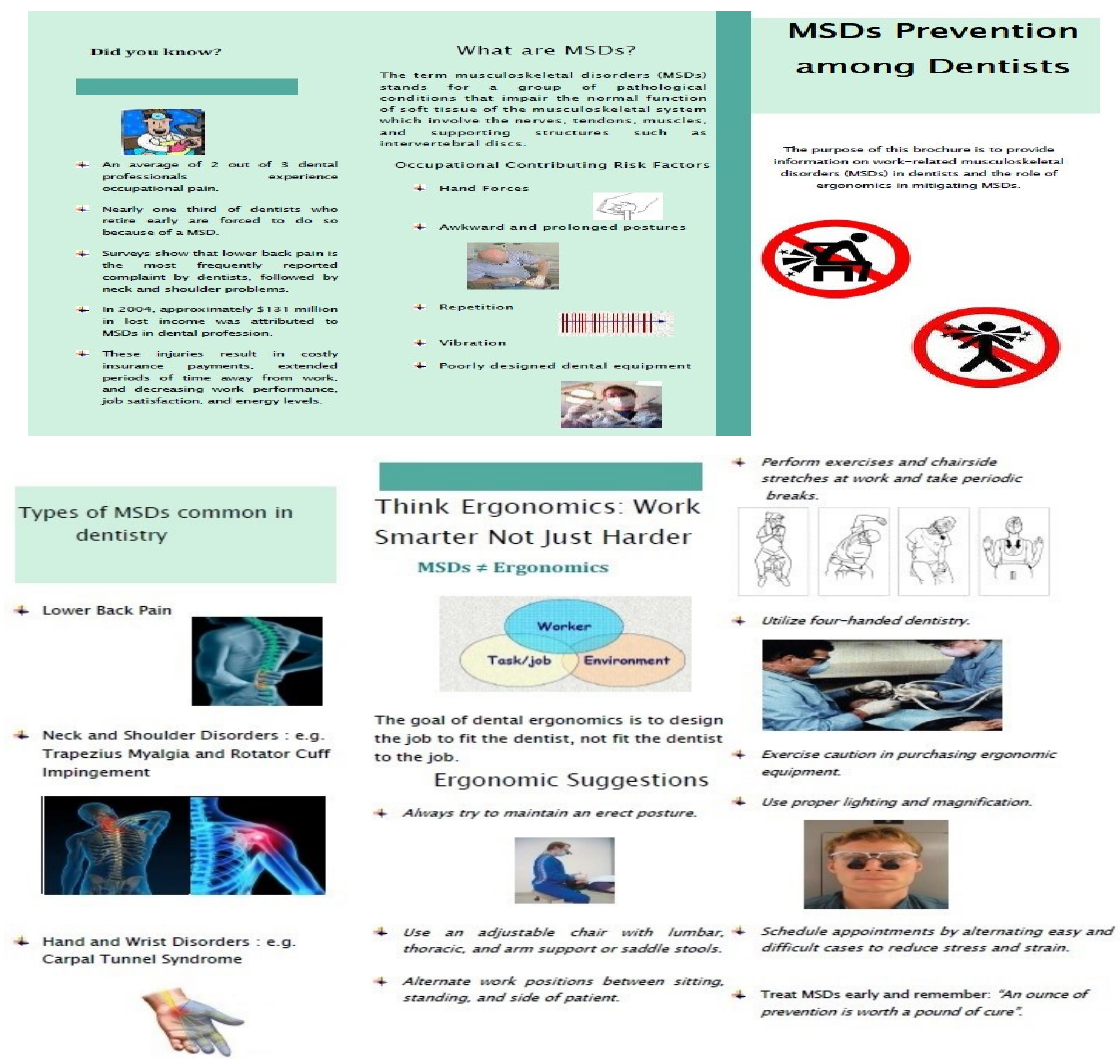
Figure A1. Informational brochure identifying work-related MSDs among dental personnel, their risk factors and evidence-based preventive ergonomic approaches.